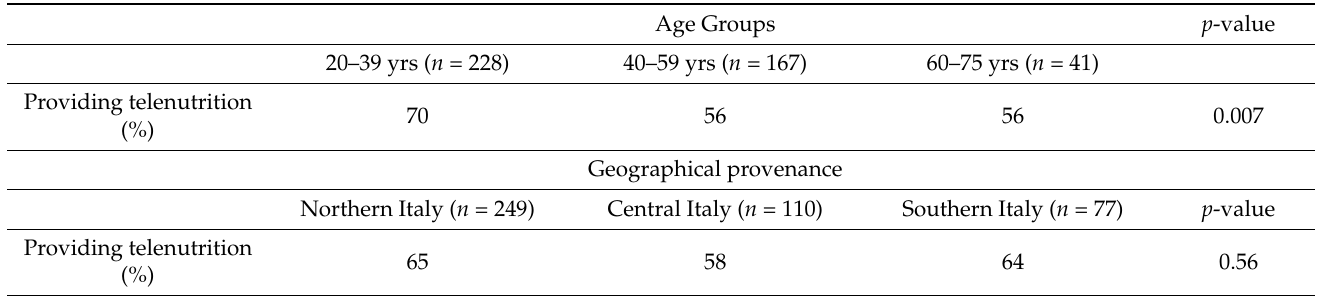
Table 4. Description of the demographic and professional characteristics of the RDNs providing telehealth during the COVID-19